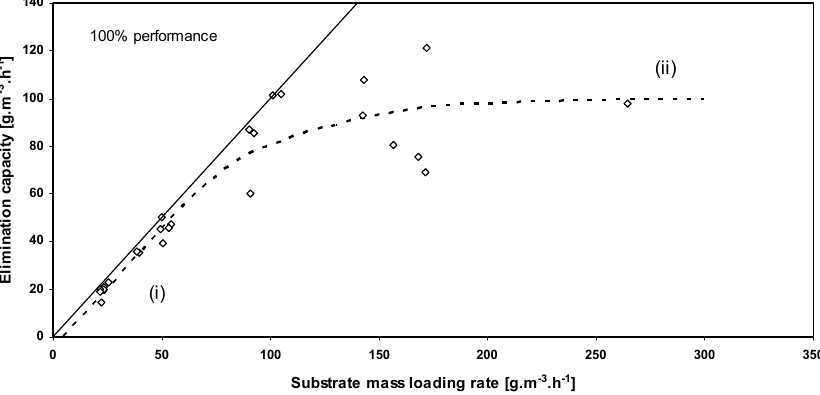
Figure 3. Effect of butanol mass loading rate on the elimination capacity of the BTF, showing (i) a linear region, and (ii) asymptotic approach to the maximum elimination capacity.